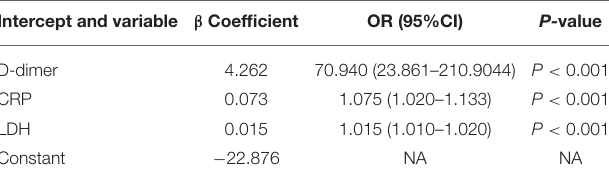
TABLE 4 | Predictive factors for RMPP by stepwise